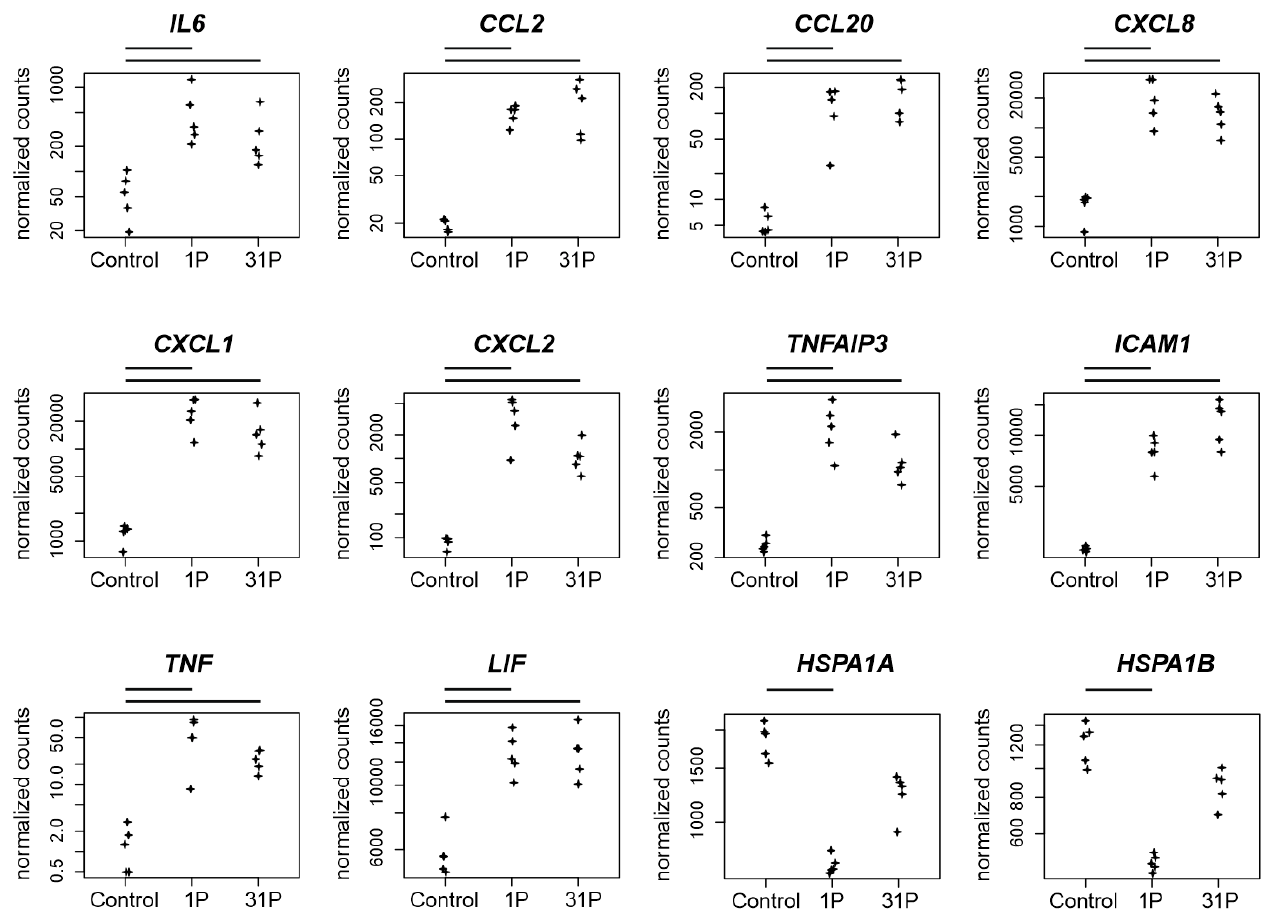
Figure 5. Normalized PF RNAseq counts of twelve candidate genes over the conditions control, 1P and 31P . Normalized mapped RNAseq read counts to the genes encodes the cytokine IL6 , two C-C motif chemokines ( CCL2 , CCL20 ), three C-X-C motif chemokines ( CXCL8 , CXCL1 , CXCL2 ), the zinc finger protein TNFAIP3 , the glycoprotein ICAM1 , the proinflammatory cytokine TNF , the pleiotropic cytokine LIF and the heat shock 70 kDa protein ( HSPA1A , HSPA1B ). Bars on top of the graph indicate two-fold significant (P adj < 0.05) differential expression between the conditions.